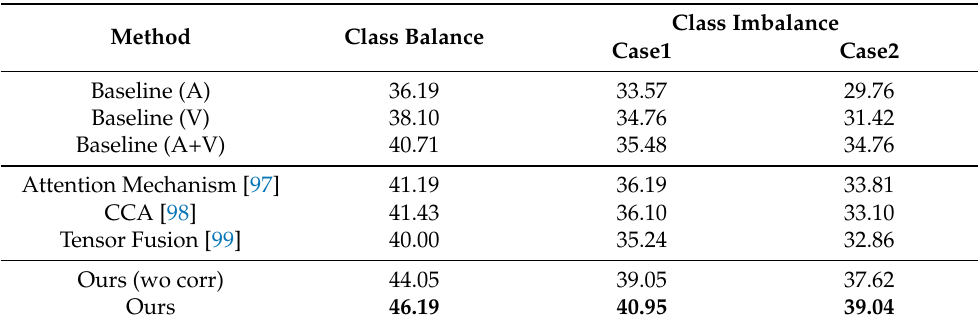
Table 9. Classification accuracy (%) of different methods when the training set is class-imbalanced on the CMEW dataset. Best results are shown in